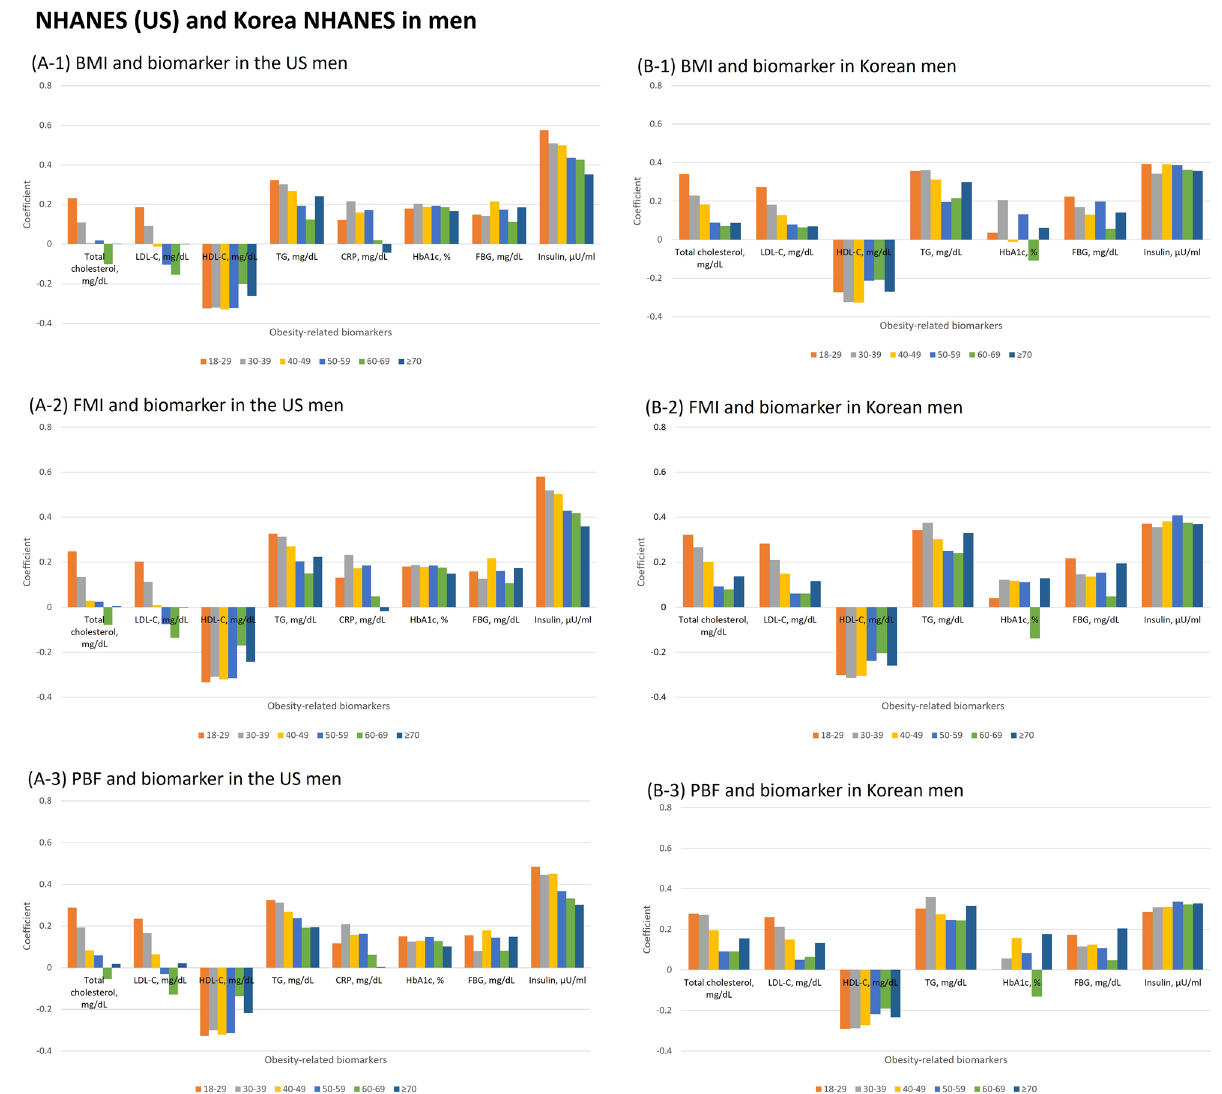
Figure 2. Pearson correlation coefficients between obesity-related biomarkers and body adiposity indices (body mass index, fat mass index and percentage body fat) by age in men. The bar graphs of panel A show coefficients between obesity-related biomarkers (total cholesterol, low-density lipoprotein cholesterol [LDL-C], high-density lipoprotein cholesterol [HDL-C], triglycerides [TG], C-reactive protein [CRP], hemoglobinA1c [HbA1c], fasting blood glucose [FBG] and insulin) and body mass index (BMI), fat mass index (FMI), and percentage body fat (PBF) in National Health and Nutrition Examination Survey (NHANES) and panel B shows the correlations in Korea NHANES. CRP was not available in Korea